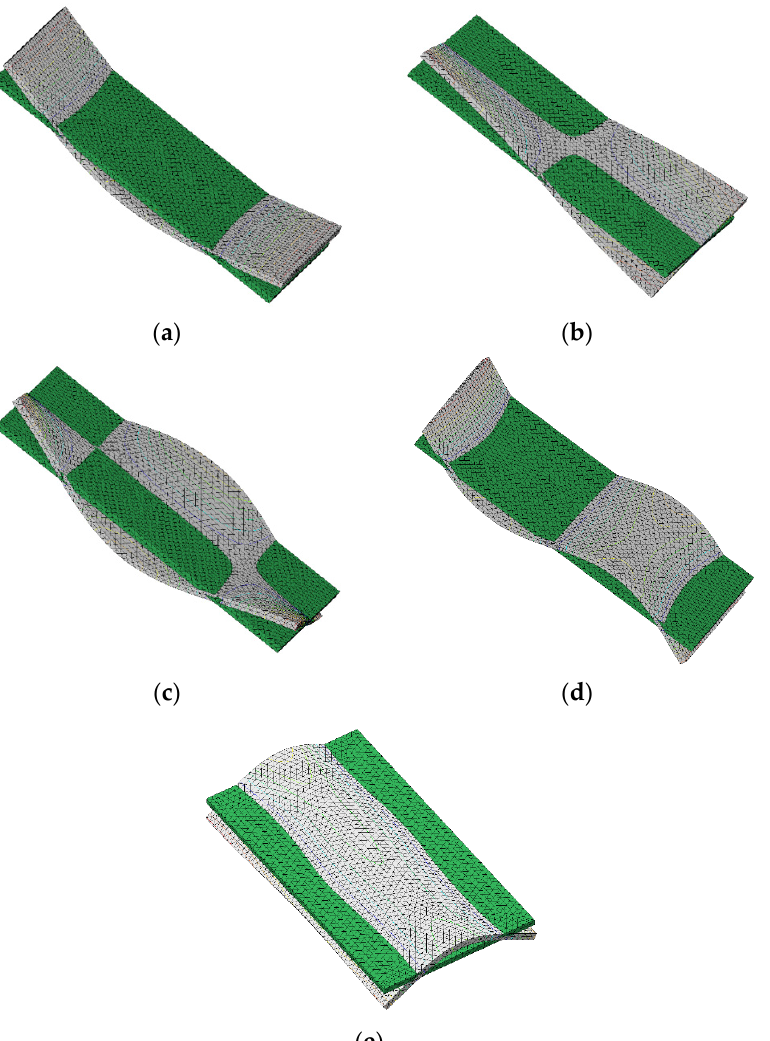
Figure 3. Mode shape of FE model of simple specimens (gray), overlapped with the original model (green): ( a ) first mode (1st bending); ( b ) second mode (1st torsional); ( c ) third mode (2nd torsional); ( d ) fourth mode (2nd bending); ( e ) fifth mode (3rd bending).